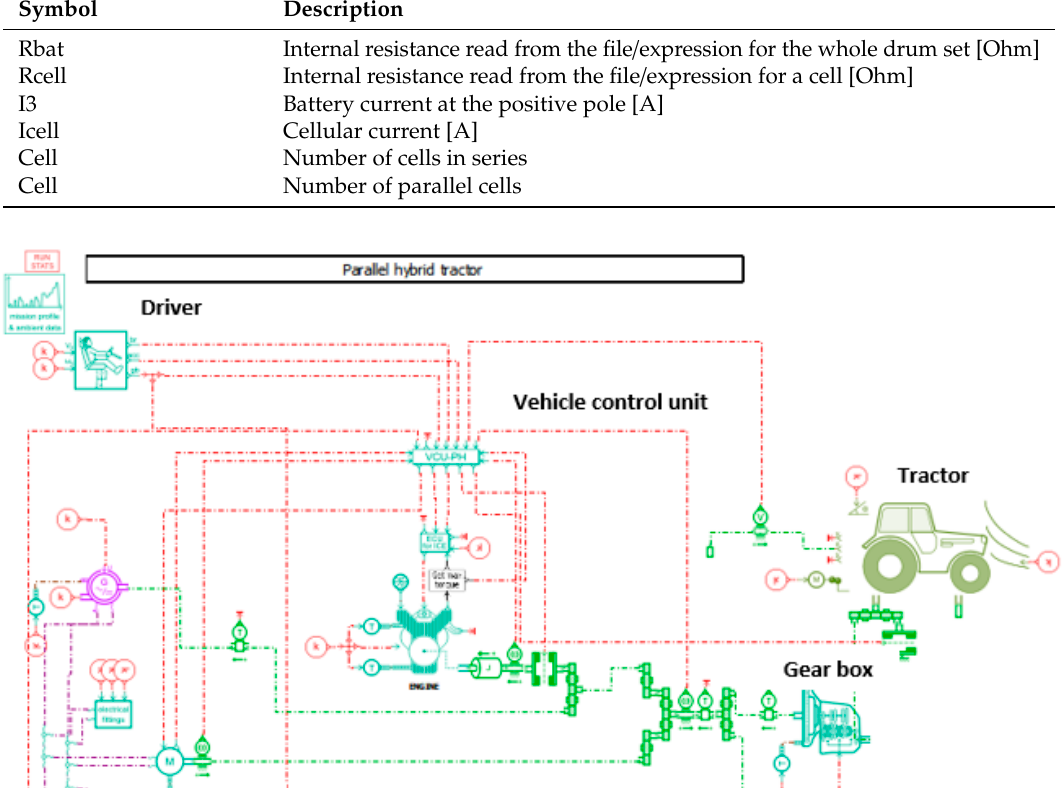
Table 1. Cont. Figure 1. Principle of parallel architecture.